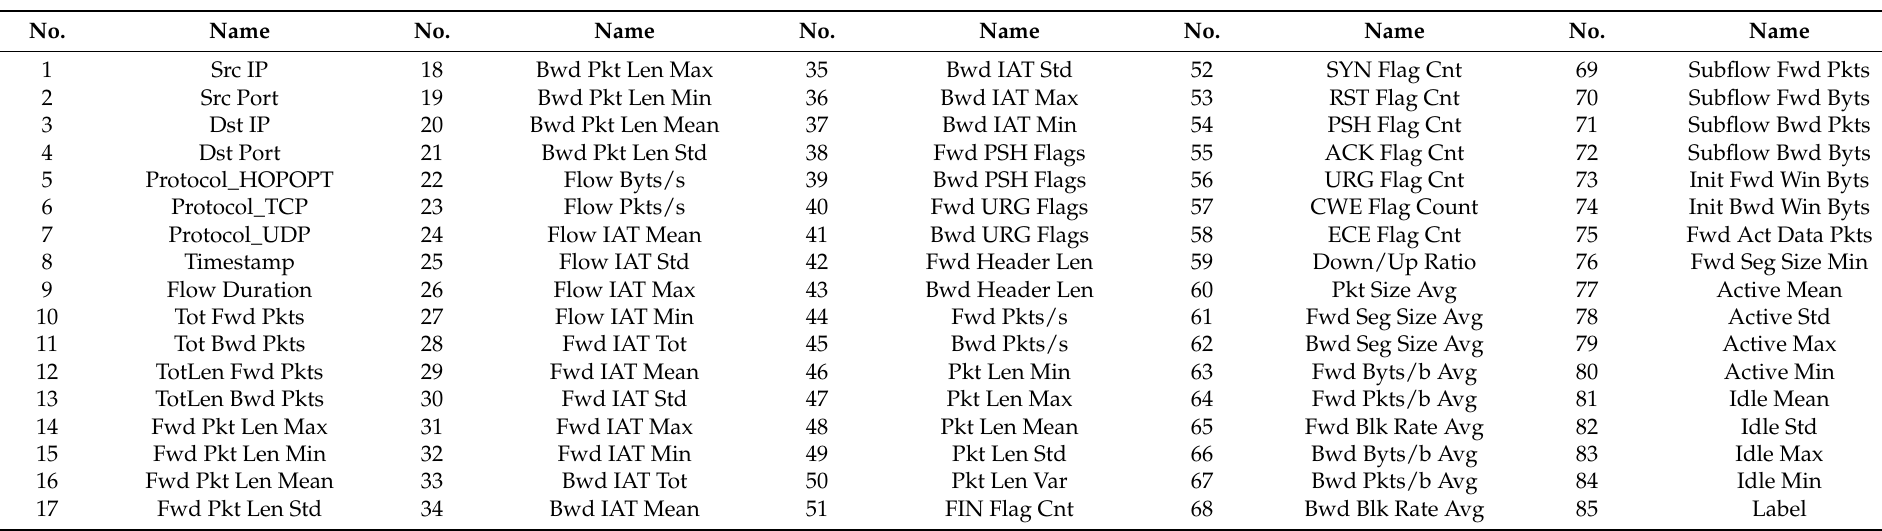
Table 1. ISCXIDS 2012 feature list showing ‘act’: active, ‘avg’: average, ‘blk’: block, ‘bwd’: backward, ‘byts’: bytes, ‘cnt’: count, ‘CWR’: congestion window reduced flag, ‘dst’: destination, ‘ECE’: explicit congestion notification for echo flag, ‘fwd’: forward, ‘IAT’: inter-arrival-time, ‘init’: initial, ‘len’: length, ‘pkt’: packet, ‘PSH’: push flag, ‘RST’: reset flag, ‘seg’: segment, ‘src’: source, ‘std’: standard deviation, ‘tot’: total, ‘URG’: urgent flag, ‘var’: variance, ‘win’: